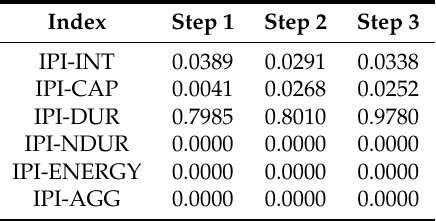
Table 23. Modified Diebold–Mariano statistics for the equality of forecast accuracy of two forecasts under general assumptions with an expanding window from 2008:01 to 2018:12. The null hypothesis is that the two methods have the same forecast accuracy. The loss function is the squared error.